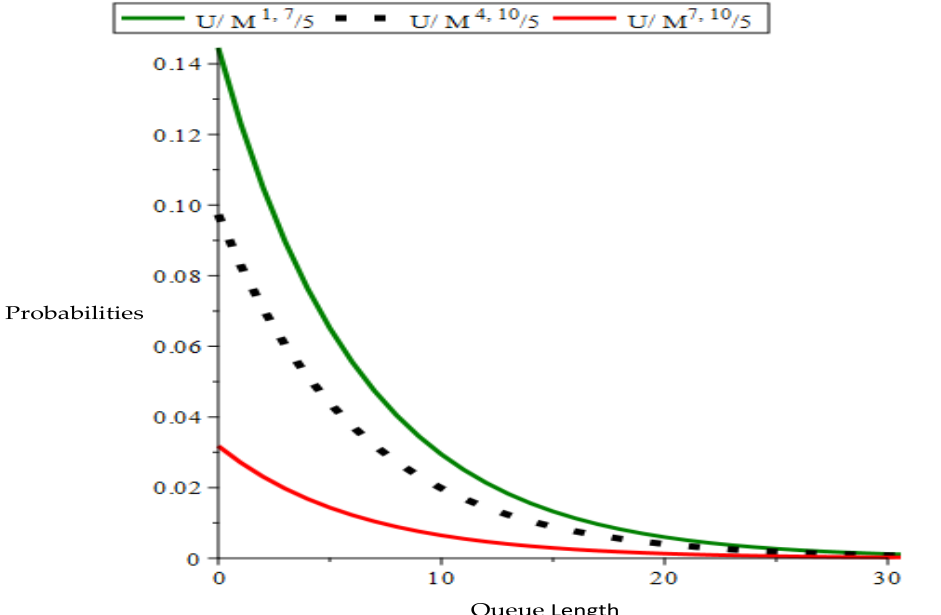
Figure 2. Comparison of performance measures of U/M a ,10 /5 for busy servers, a = 1, 4, 7, ρ = 0.5, ε = 10 − 20